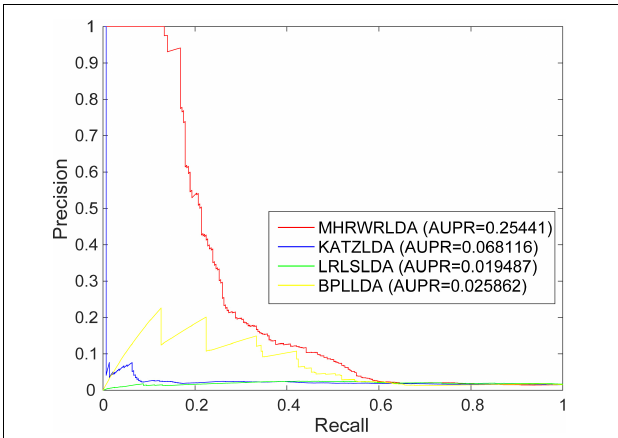
TABLE 5 | The predicted top five novel disease correlated with MALAT1, PVT1, and